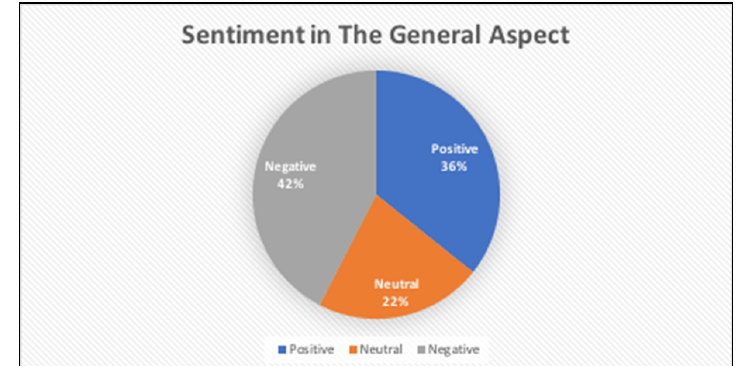
Fig. 5 The graph of sentiment in the general aspect